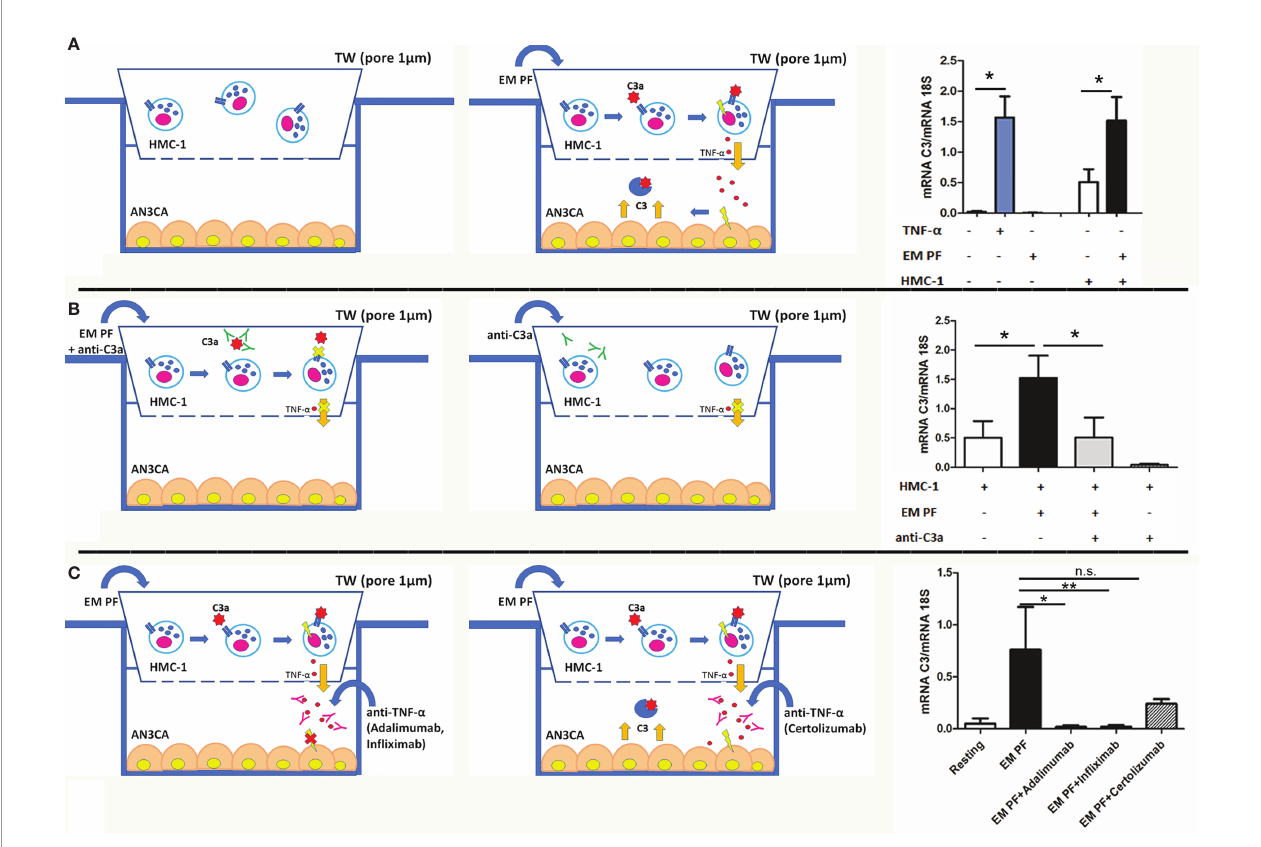
FIGURE 4 | The co-culture of MCs with endometrial cells, in the presence of EM-PF, induced the expression of C3, which was inhibited by C3a blocking antibody. (A) The C3 gene expression was evaluated by RT-qPCR on endometrial AN3CA cells alone (resting conditions), stimulated with TNF- a (+TNF- a ) or with a pool of EM peritoneal fl uid (+EM-PF); or co-cultured with MCs alone (+HMC-1), or with EM-PF (+HMC-1+ EM-PF). Similar experiments were performed in the presence of anti- C3a blocking antibody (B) , or in the presence of anti-TNF- a blocking antibodies [(In fl iximab, Adalimumab or Certolizumab), (C) ]. In the left part of the fi gure the graphical representations of the blocking co-culture experiments. Data are expressed as mean of three independent experiments conducted in double ± standard error. *p < 0.05, **p < 0.01, n.s., not signi fi